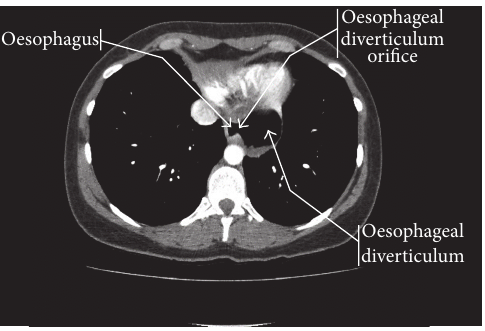
Figure 1: Epiphrenic oesophageal diverticulum containing food residue. CT chest with IV contrast.